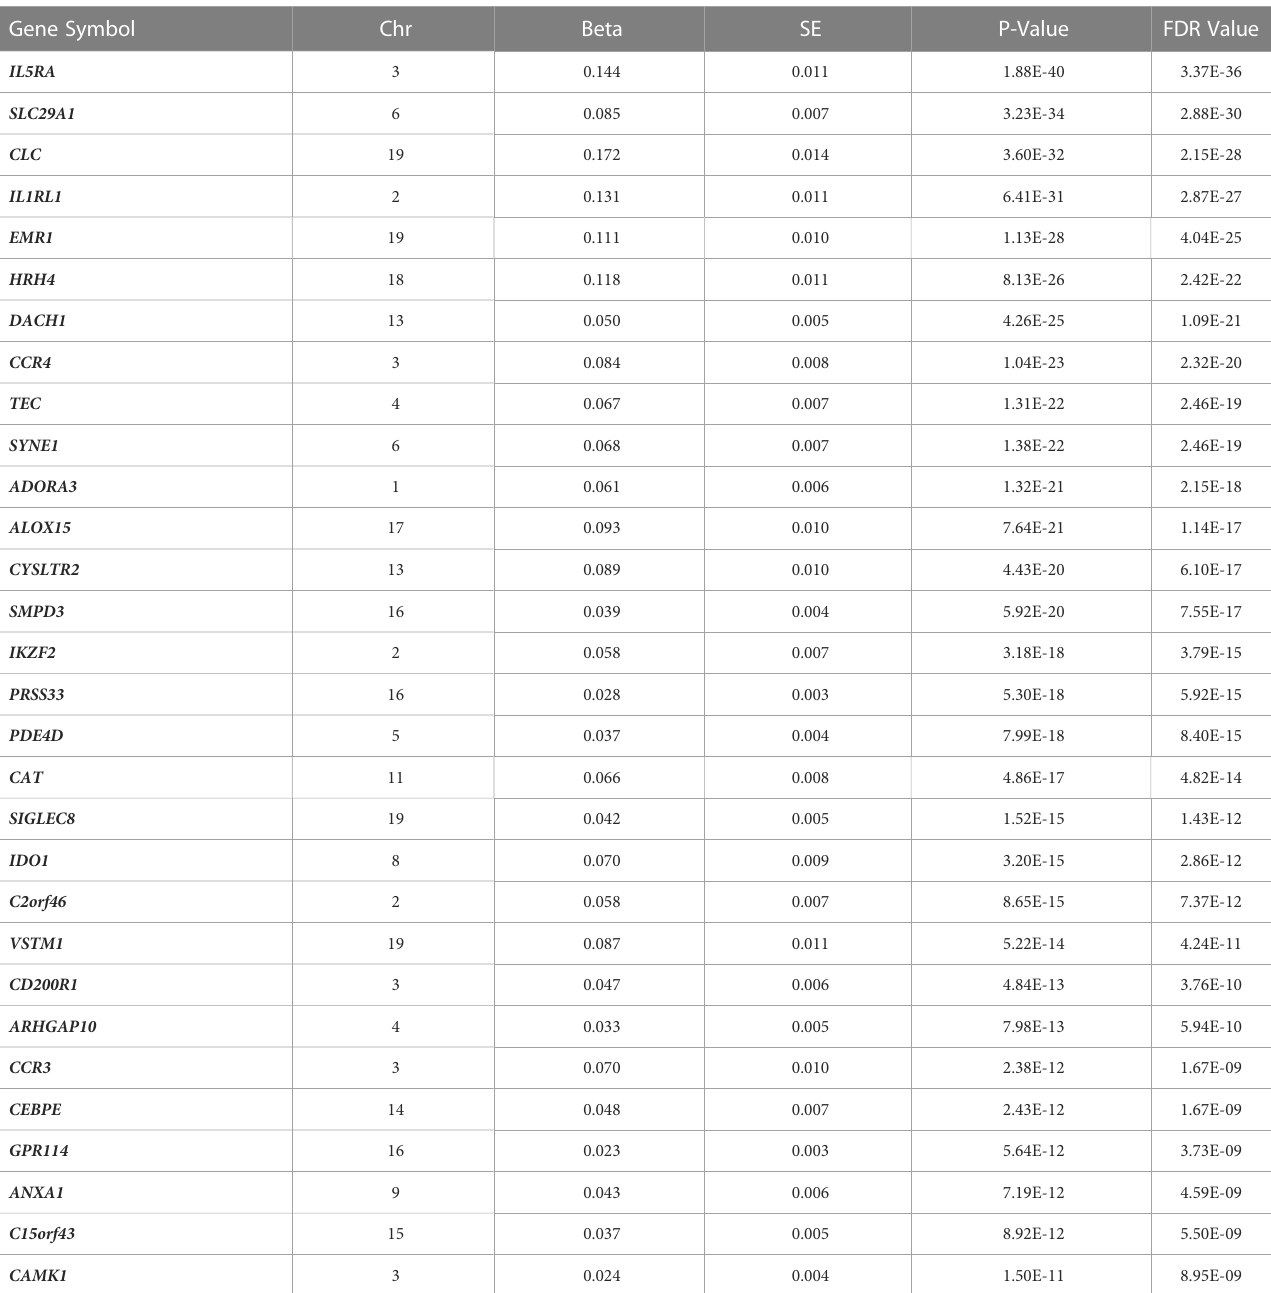
TABLE 2 Top thirty genes associated with total IgE levels in the FHS. Gene Symbol Chr Beta